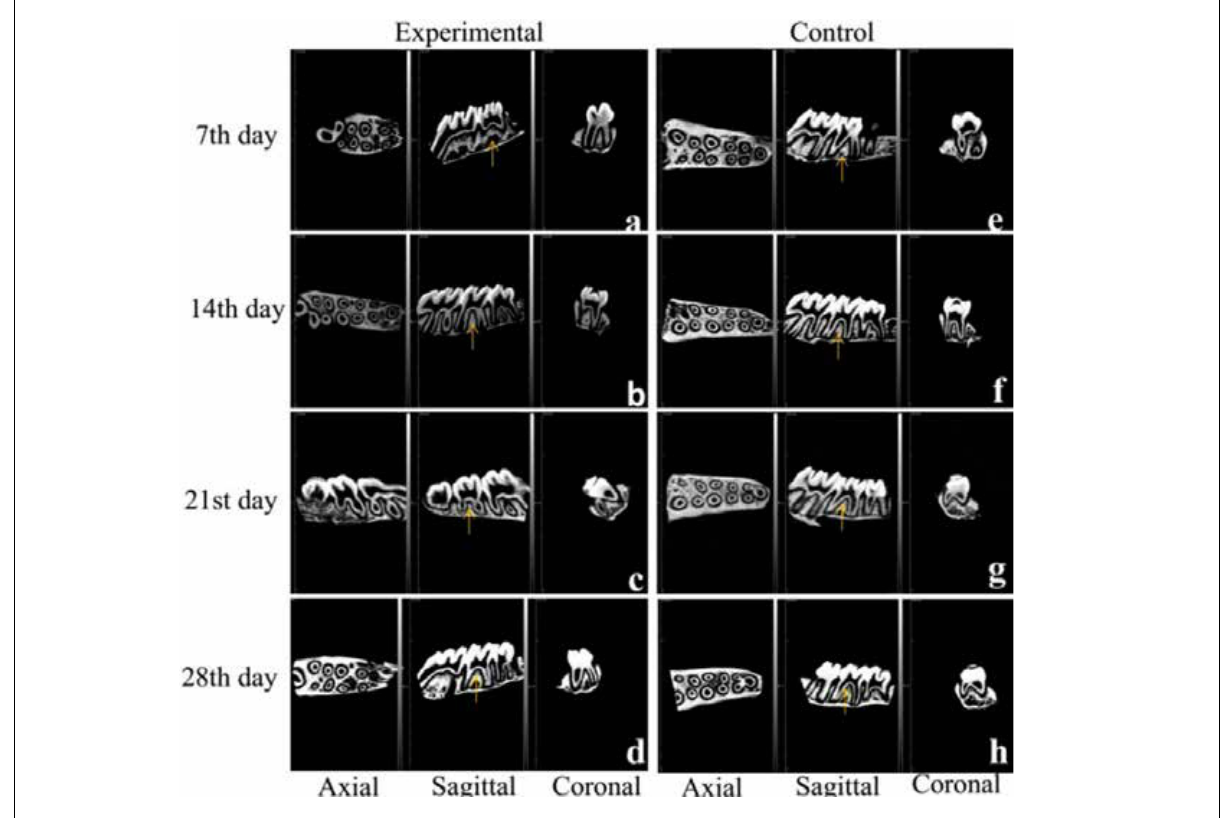
Arrows: collection of BMD. Figure 2. Micro-CT images of the left hemi-maxilla alveolar bones.